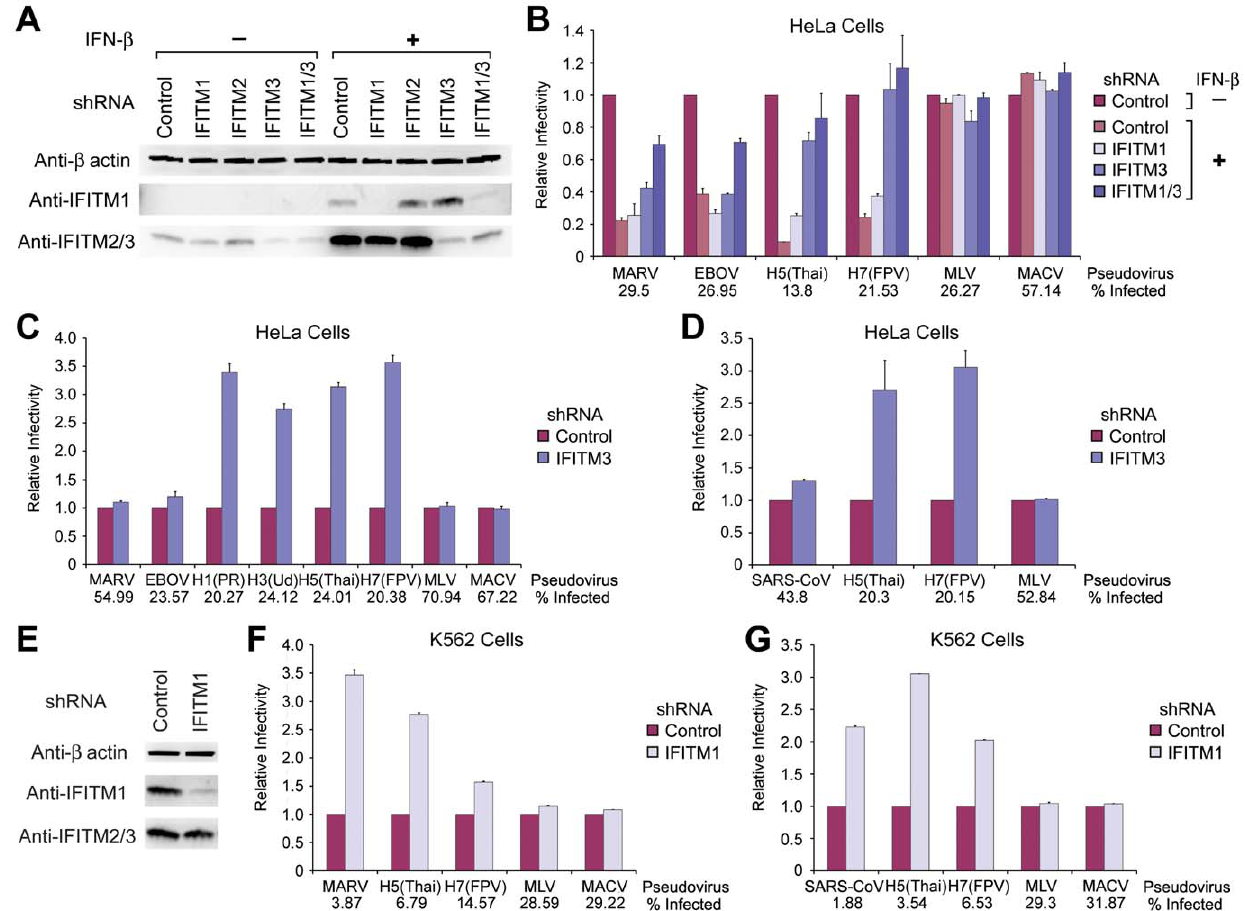
Figure 4. Depletion of IFITM proteins differentially enhances infection mediated by MARV, EBOV, SARS-CoV, and IAV entry proteins. ( A ) HeLa cells were transduced to express control shRNA or shRNA targeting IFITM1, 2, 3, or IFITM1 and 3 (IFTIM1/3), and selected by puromycin. HeLa cells were then treated with 1000 U/ml IFN- b or with medium alone for 48 hours. Expression of IFITM proteins in control or IFITM depleted HeLa cells was assayed by western blot using the indicated anti-IFITM1 or anti-IFITM2/3 antibody. b -actin was included as a loading control. ( B ) Aliquots of the cells used in (A) were infected with MLV-GFP pseudotyped with the indicated entry proteins. Pseudovirus infection was measured by flow cytometry, and normalized to infection of cells expressing control shRNA in the absence of IFN- b . Differences in pseudovirus entry between IFN- b -treated and untreated cells for MARV, EBOV, or IAV are significant ( P , 0.05), except for IAV entry into HeLa cells expressing IFITM3 or IFITM1/3 shRNA. ( C ) Experiment similar to (B) except HeLa cells stably expressing indicated shRNA were assayed in the absence of IFN- b . ( D ) HeLa cells expressing indicated shRNA were transduced to express ACE2 and infected with indicated pseudoviruses. Differences in pseudovirus entry between cells expressing control and IFITM3 shRNA in (C) and (D) are significant ( P , 0.05) for IAV pseudoviruses only. ( E ) Experiment similar to (A) except that K562 cells were transduced to express control shRNA or shRNA targeting IFITM1, and selected by puromycin. ( F ) Experiment similar to that in (B) except that infectivity of the indicated pseudoviruses was measured in K562 cells stably expressing the indicated shRNA. ( G ) Experiment similar to (D) except that infectivity of the indicated pseudoviruses was measured in ACE2- and shRNA-expressing K562 cells. Differences in pseudovirus entry between cells expressing control and IFITM1 shRNA in (F) and (G) were significant ( P , 0.05) for MARV, SARS-CoV, and IAV pseudoviruses. Each panel of the figure represents at least two experiments with similar results.